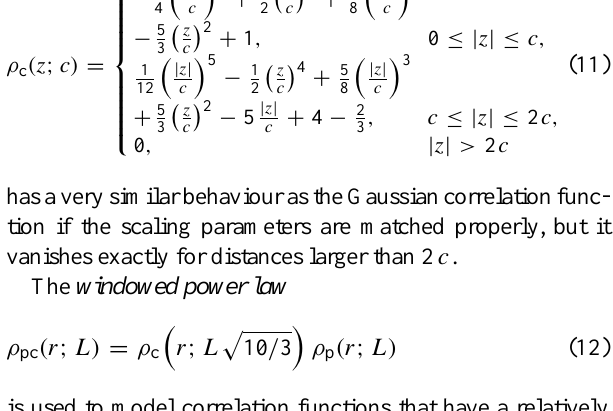
Fig. 2. Model domain for the summer case Hybrid variational en- semble data assimilation experiments.